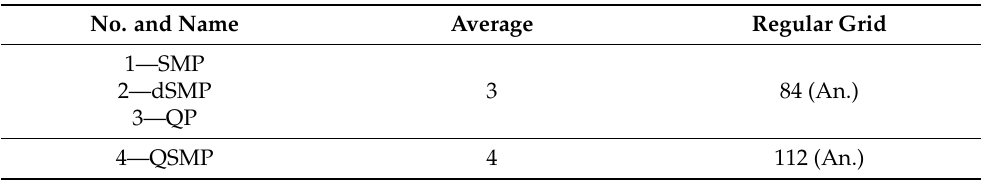
Table 4. Number of inputs for the ANN model depending on the combination of variables and the spatial distribution. With a regular grid, information is only given for the Androscoggin watershed (An.). No. and